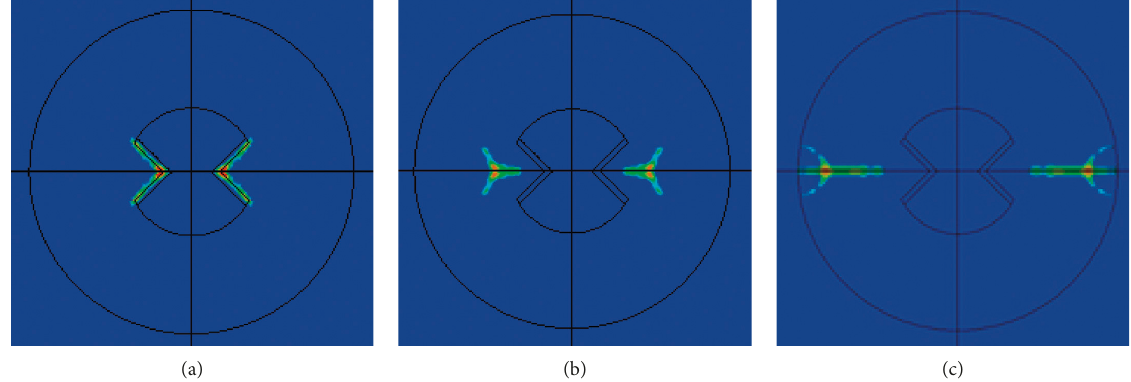
Figure 7: Process of shaped charge jet formation and migration under cumulative blasting with decoupling coefficient 2.5: (a) t � 4.28 μ s; (b)